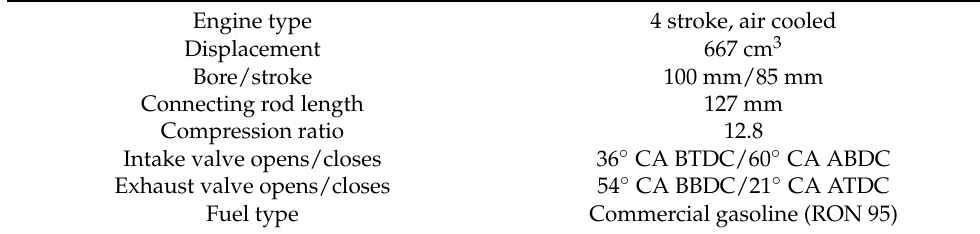
Table 1. Specifications of 1-cylinder research engine.